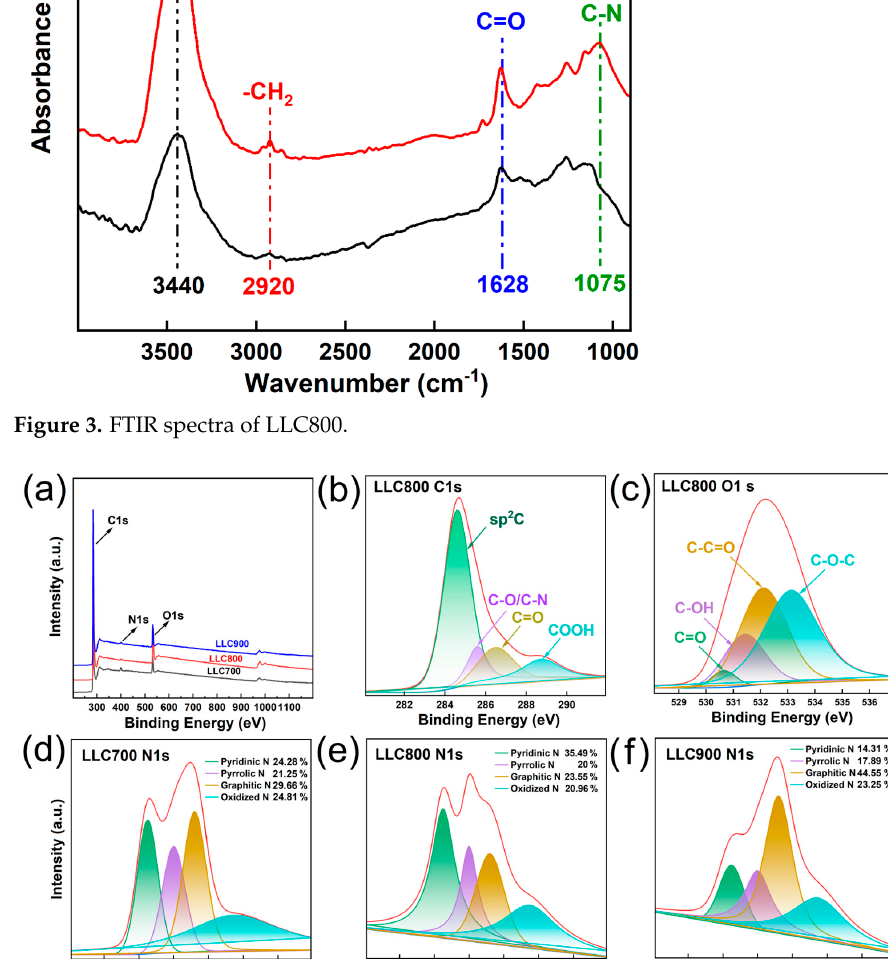
To investigate the removal effect of AO7 under different systems, different activation reaction systems were constructed (the reaction temperature was 25 °C, the concentration of AO7 was 200 mg/L, the dosage of LLC was 0.25 g/L, the dosage of PS was 4 g/L). The system containing only PS had almost no effect on the removal of AO7 at a reaction time of 30 min, which was only 0.84% (Figure 5). The removal of AO7 by LLC700, LLC800 and LLC900 at 30 min was 7.09%, 31.11% and 20.61% in the system containing only LLC, which was consistent with the LLC surface area size pattern. The removal of AO7 by LLC700/PS, LLC800/PS and LLC900/PS at 30 min was 9.88%, 99.46% and 51.30%, respectively, when LLC and PS were present simultaneously. The higher removal rate of AO7 by the LLC800/PS system compared to LLC800 and PS alone may be attributed to the larger spe- cific surface area of LLC800. That is, the removal rate of AO7 by different LLC/PS systems is positively correlated with the specific surface area of LLC. Obviously, LLC800 has ex- cellent adsorption performance and efficient catalytic performance.